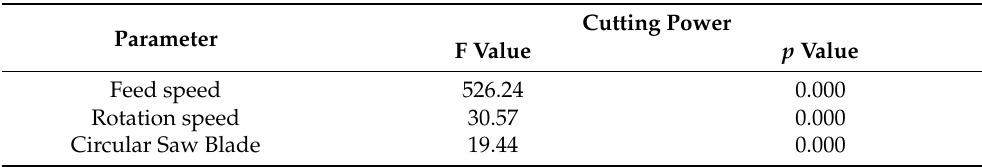
Table 4. Analysis of variance showing the influence of the circular saw blade, feed speed, and rotation speed on the cutting